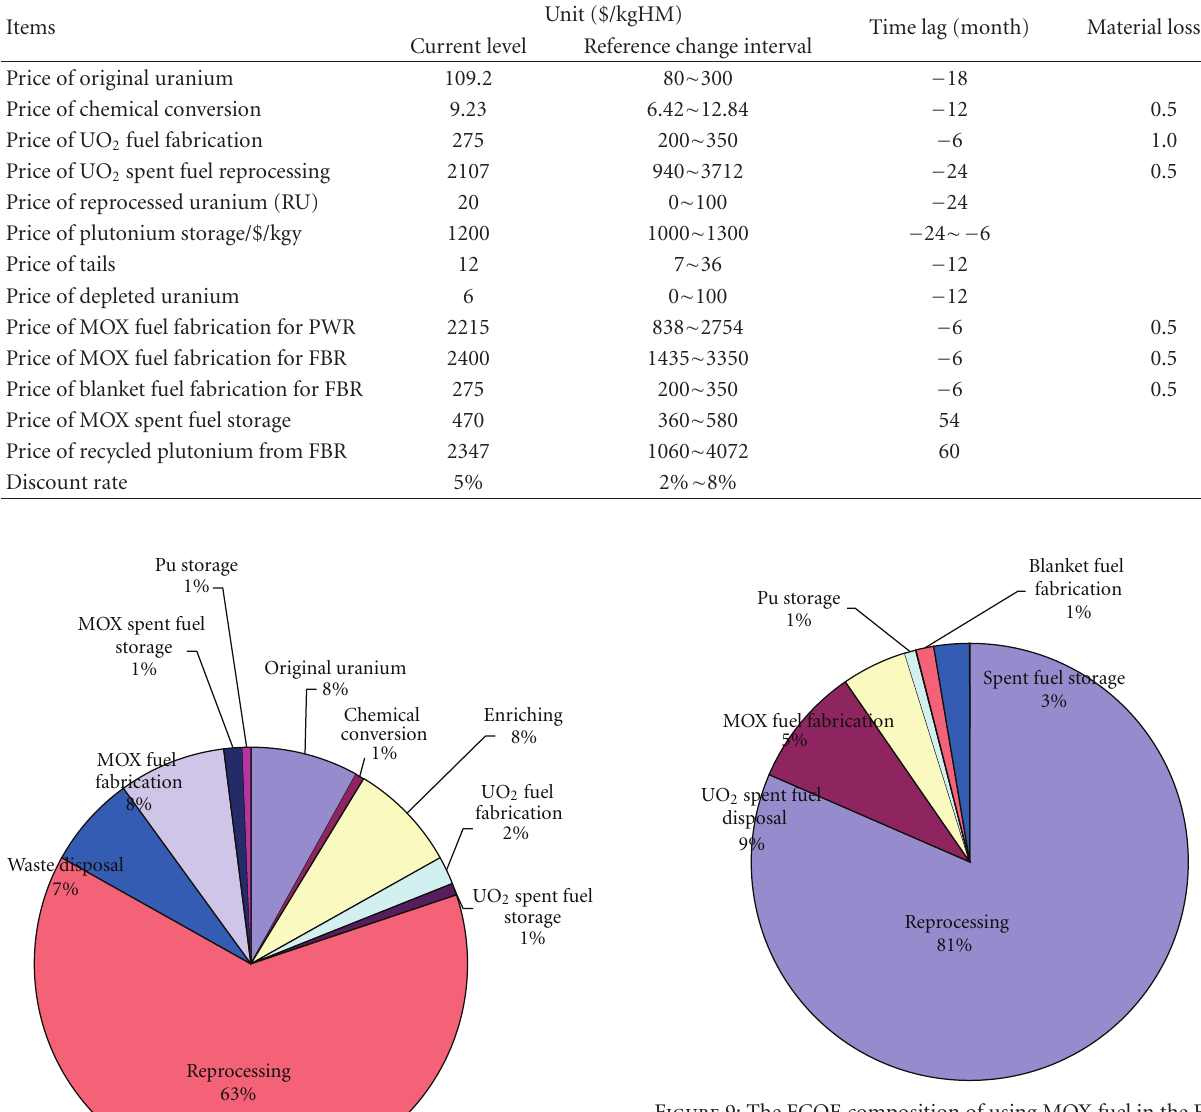
Figure 9: The FCOE composition of using MOX fuel in the